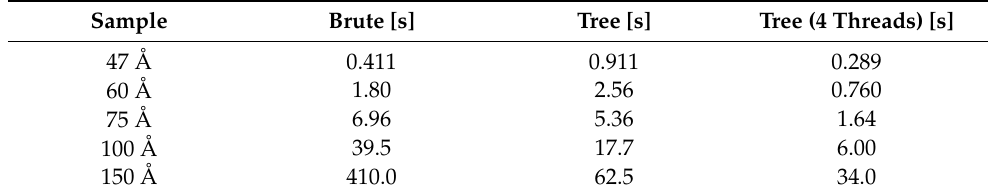
Table 3. Computational cost of a single attosecond timestep in XMDYN, when using our new tree- based algorithm for calculation of secondary ionization. It was calculated for samples of different size (first column) when using Coulomb brute-force scheme (second column), single threaded Coulomb PEPC tree code (third column), and the 4 threaded Coulomb PEPC solver (fourth column).